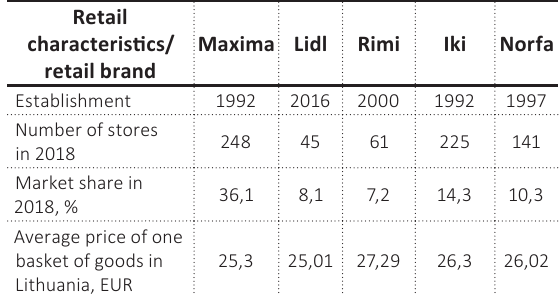
Table 1. Comparison of the biggest retail brand